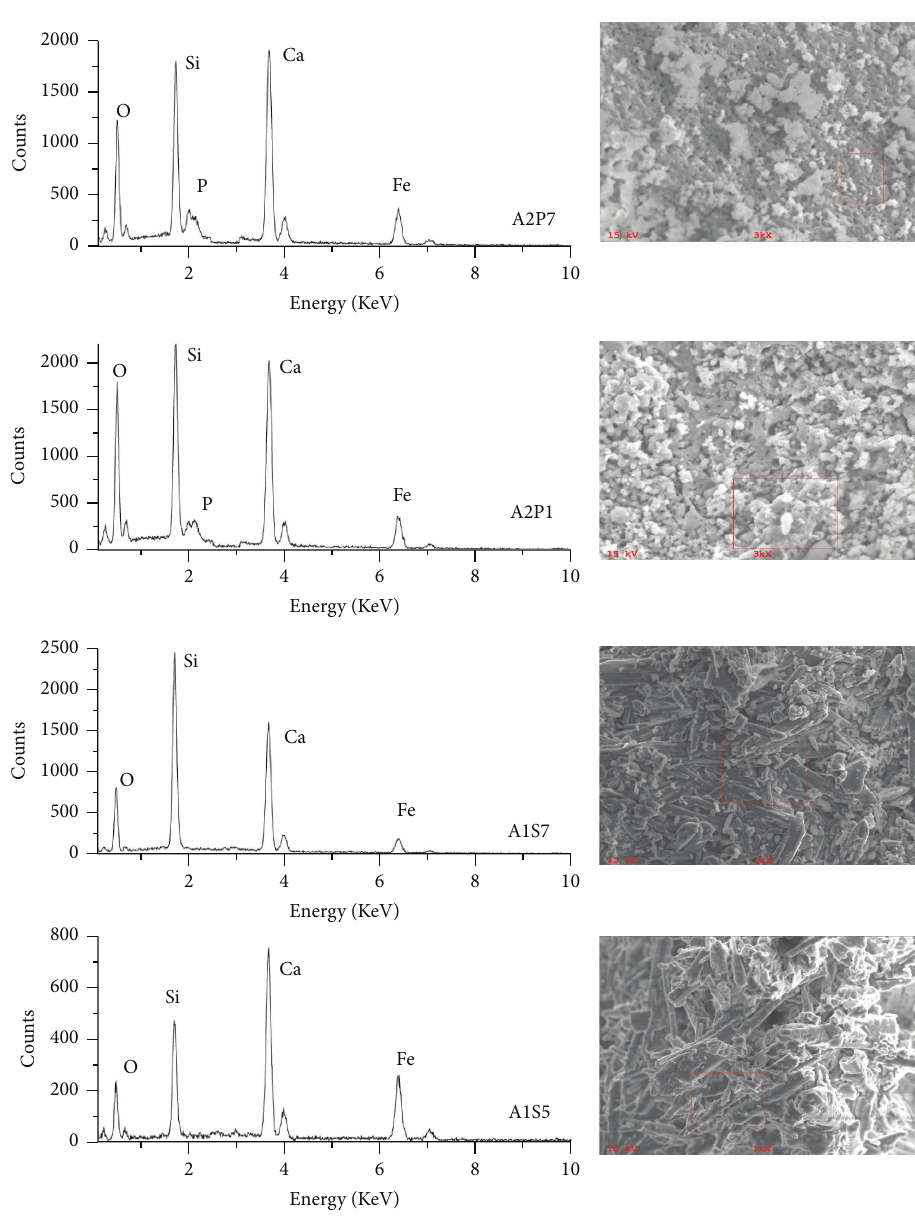
Figure 3: SEM-EDS spectra and images of the samples.